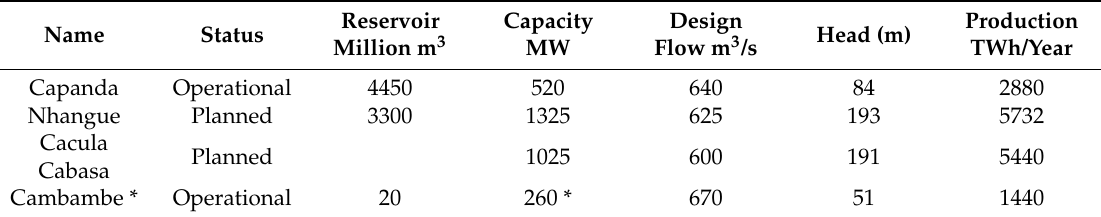
Table 1. Characteristics of major hydropower projects in Kwanza River Basin, Angola.